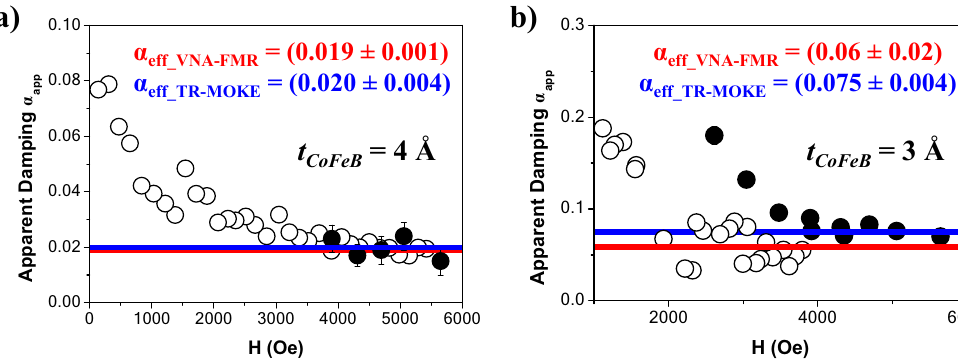
Figure 5. Apparent damping α app as a function of the external applied magnetic field for CoFeB layer thickness of t CoFeB = 4 ( a ) and 3 ( b ), extracted from VNA-FMR spectra (blavk open circle) and pump-probe measurements (black filled circle). The red (blue) solid lines are the average of α app determined from the VNA- Å FMR spectra (pump-probe measurements) for large applied fields and correspond to the α eff .